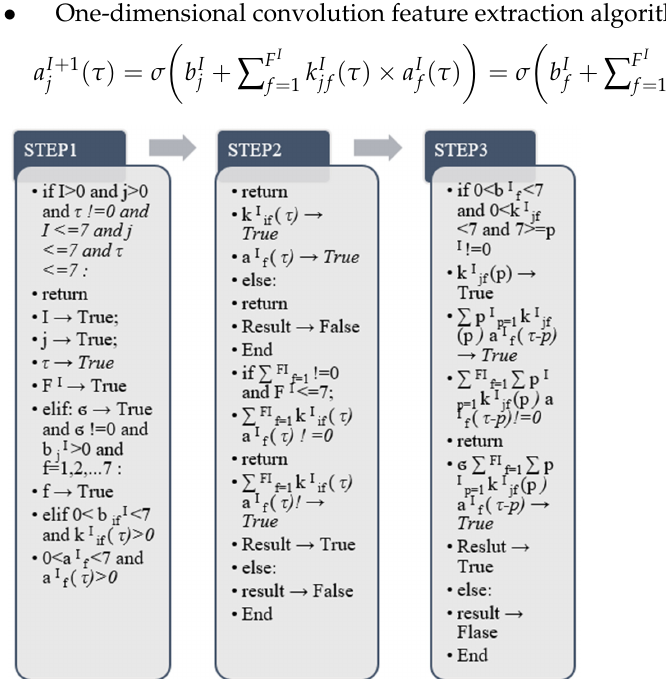
Figure 7. One-dimensional convolution recognition algorithm output.